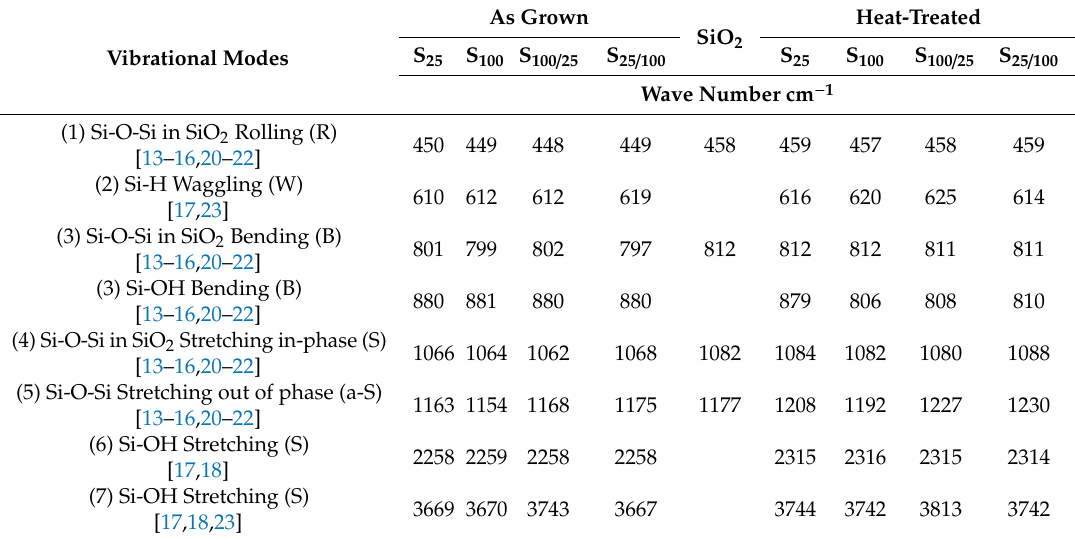
Table 3. IR vibration bands of the SiOx as-G and HT SRO